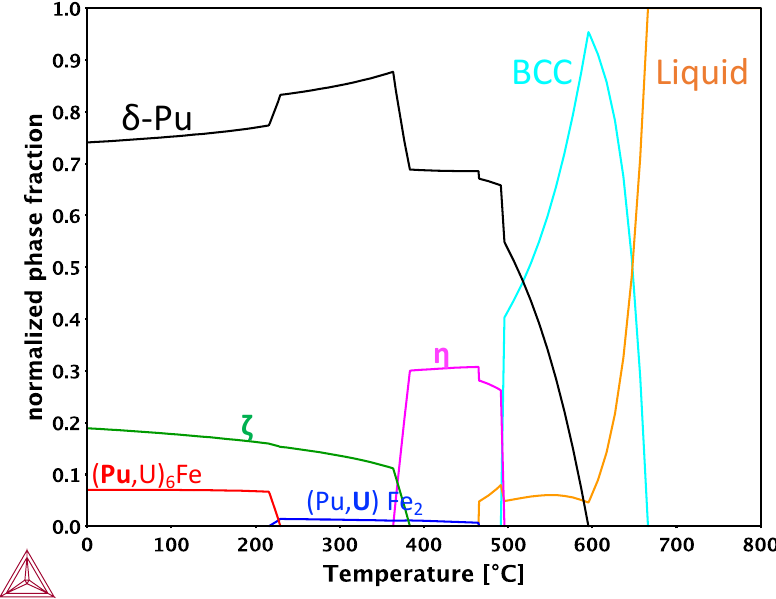
Figure 10. Property diagram of Pu 89 -U 5 -Ga 5 -Fe 1 (at. %) calculated using the present CALPHAD database .